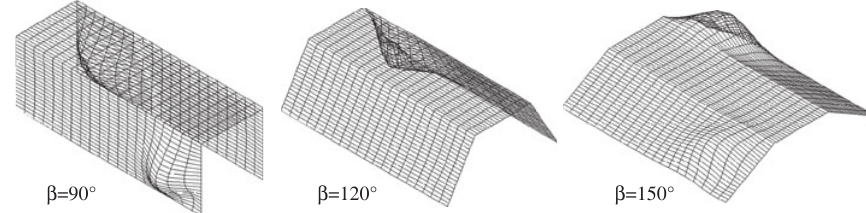
Figure 5 Thermal buckling modes for different crank angles of two-fold laminated plates.